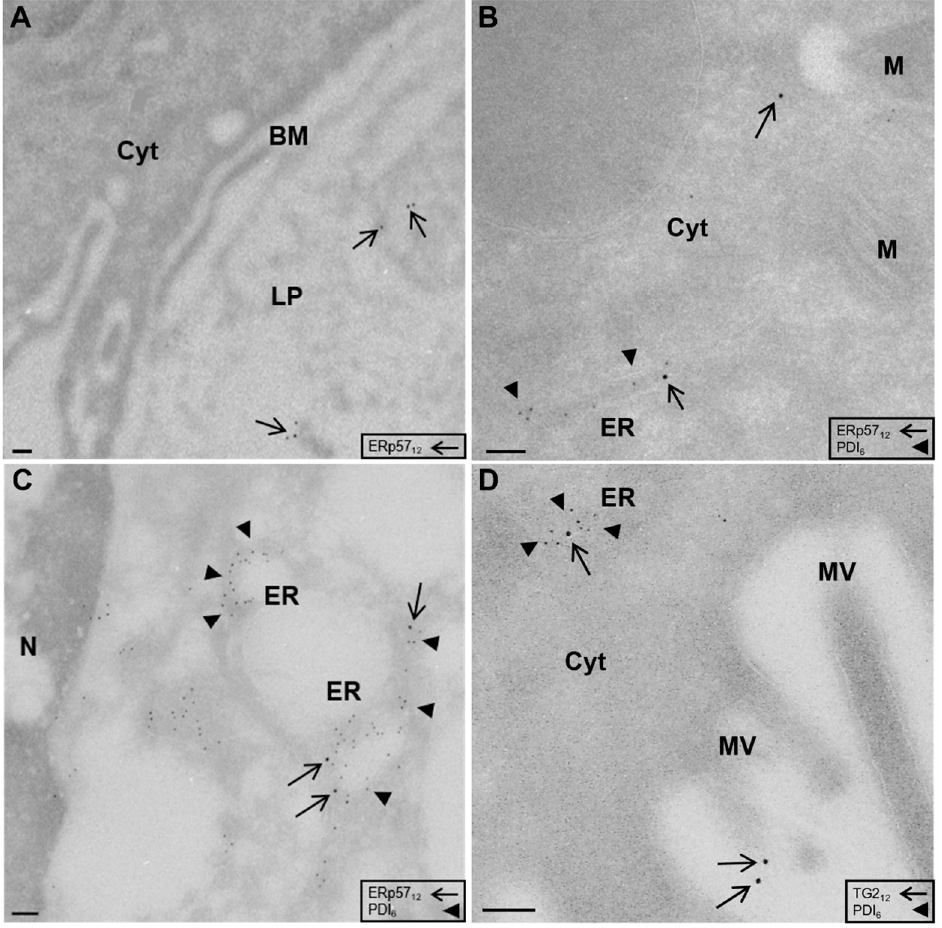
Figure 1. Localization of endoplasmic reticulum-resident protein 57 (ERp57) in the ER and the lamina propria of duodenal biopsies. ( A ) Electron microscopical localization of ERp57 (arrows) within intestinal lamina propria of human duodenal epithelium (CD patient, magnification × 10,200). ( B ) Presence of ERp57 (arrows) within the ER (labelled by PDI, arrowheads) and the cytosol of an enterocyte (NCD patient, magnification × 17,700). ( C ) Detection of ERp57 (arrows) within the dilated perinuclear ER (arrowheads) of RACE characterized by electron lucent cytosol (NCD patient, magnification × 17,700). ( D ) TG2 (arrow) within the ER (arrowhead) and at the apical membrane of an enterocyte (CD patient, magnification × 17,700). BM, basolateral membrane; Cyt, cytosol; LP, lamina propria; M, mitochondria; MV, microvilli; N, nucleus. Scale 100 nM.